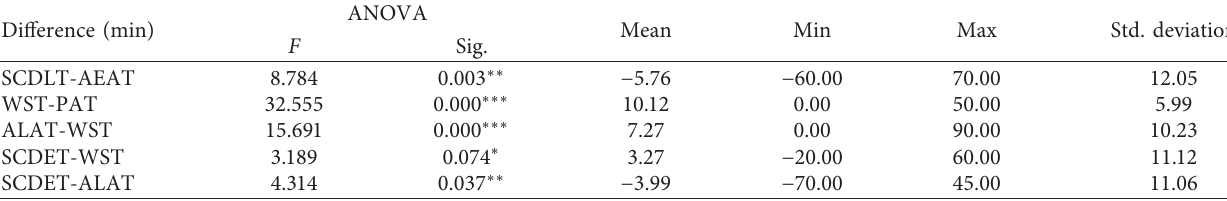
Table 6: The differences between alternative reference points of arrival time valuation.